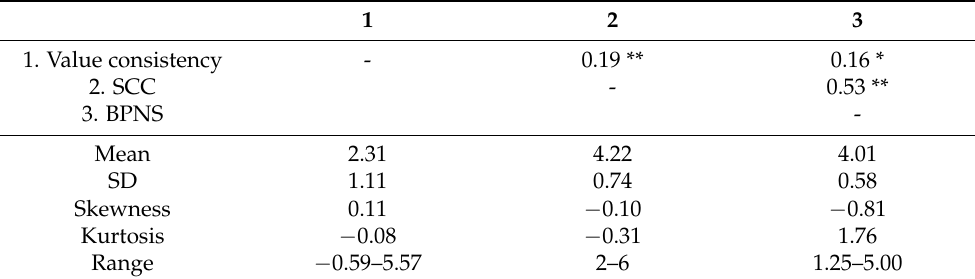
Table 2. Descriptive statistics of mediation model variables and their correlations. 1